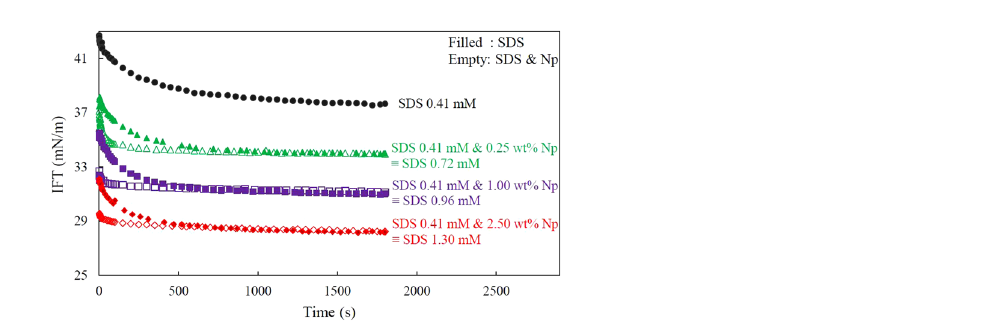
Figure 3. Variation of surface pressure and standard deviation of fitting the Laplace equation during drop compression of two SDS solutions (0.05 and 0.10 CMC) and SDS solution (0.05 CMC) mixed with 1 wt.% nanoparticle (Levasil 300/30, 9 nm). Π : surface pressure, STD: the standard deviation of fitting the Laplace equation, A/A0: the normalized surface area of droplet in respect to its initial value. The average error per point for surface pressure results is less than 0.3 mN/m and for standard deviation results is insignificant.